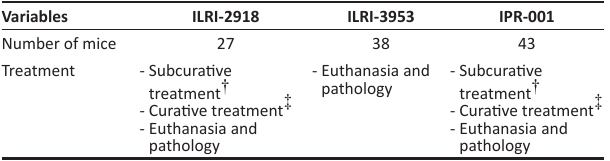
TABLE 1: Experimental